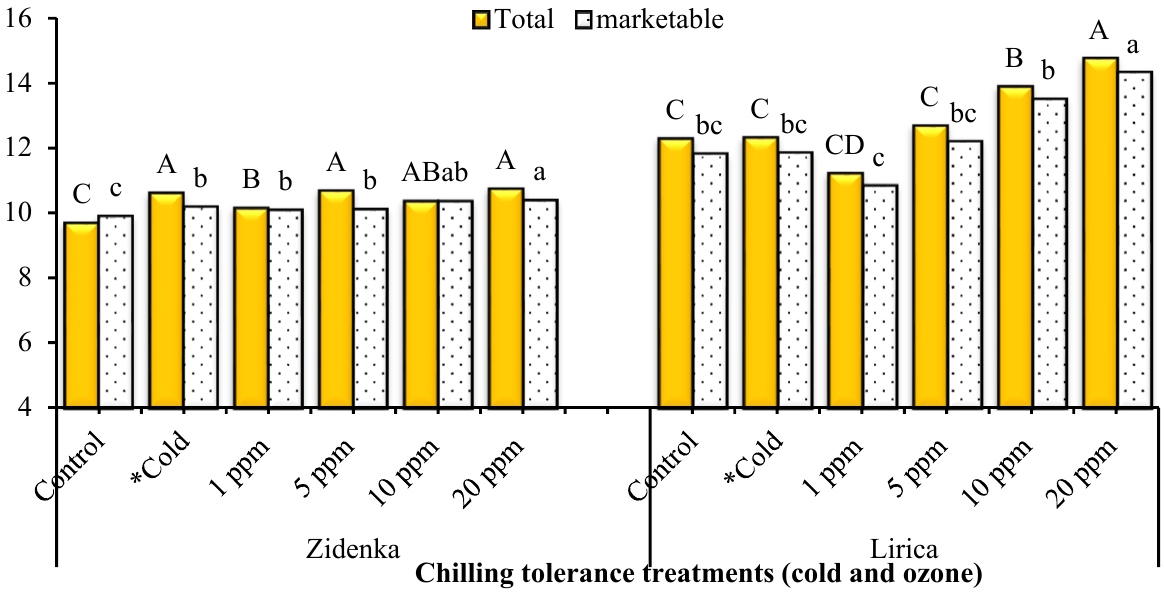
Figure 6. Effect of seed soaking in different ozonated water concentrations and cold pretreatments on total and marketable fruit yields of two sweet pepper hybrids during the 2017/2018 (upper fig- ure) and 2018/2019 (lower figure) seasons. The columns labeled with different letters with in the same case are significantly different according to Duncan’s multiple range test at 0.05 levels. * Cold stress treatment was performed at 4 °C for 36 h.